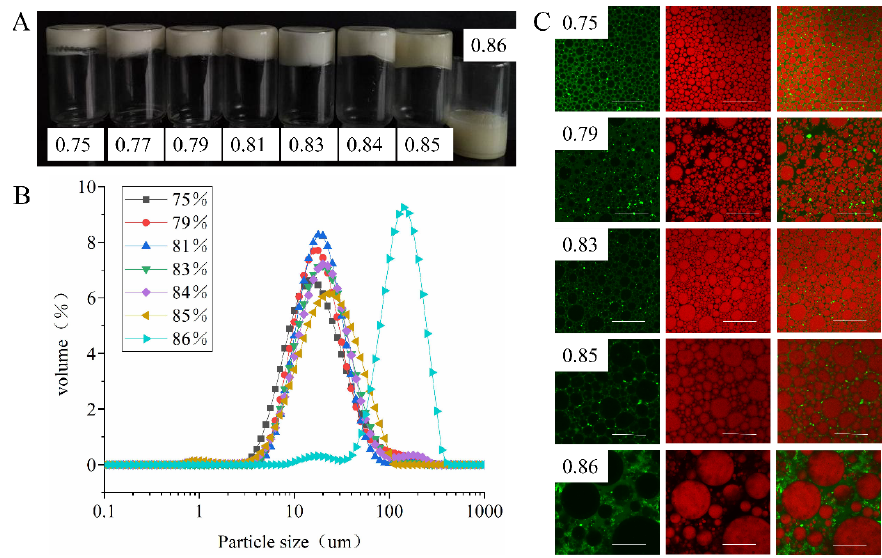
Figure 7. The visual observation ( A ), particle size distribution ( B ), and CLSM images ( C ) of HIPEs stabilized by EYGs with the different oil phases. The concentration of EYGs was 3.0 wt%, and the NaCl ionic strength was 0.3 M. The corresponding bar is 100 µm.